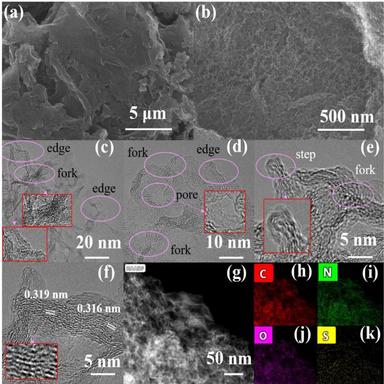
(a, b) SEM, (ced) TEM, and (eef) HRTEM images of CNS catalyst. Inset: enlarged defects of the selected area. (gek) TEM and EDS images of C, N, S, and O elements in CNS catalyst. (A colour version of this figure can be viewed online.)